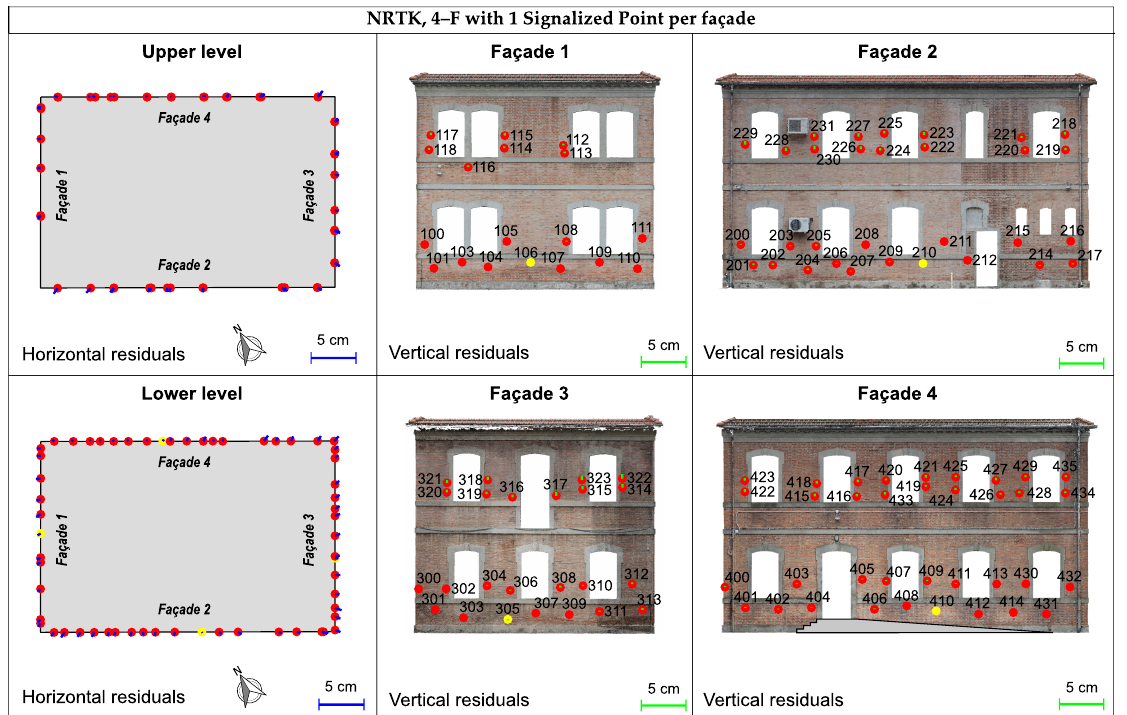
Figure A6. Horizontal and vertical residuals for NRTK image dataset processed as an overall block (4–F) with the introduction of one SP per façade (used as a GCP and shown in yellow).